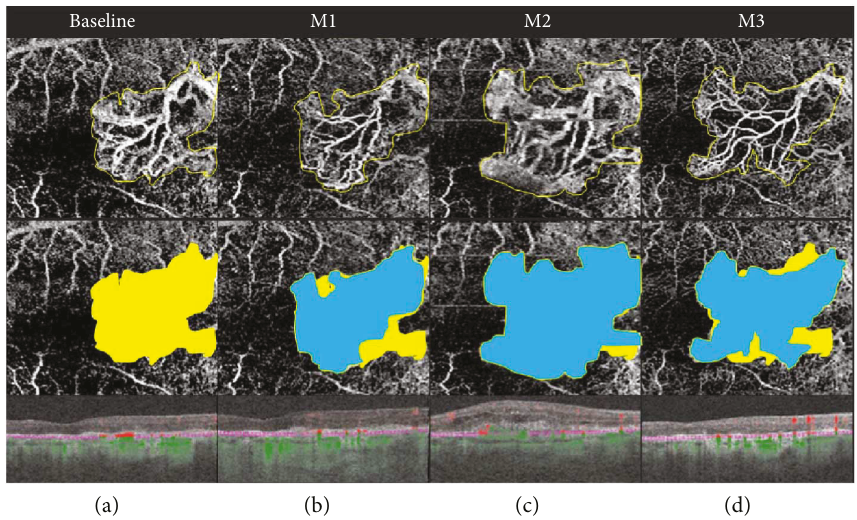
Figure 2: OCTA follow-up of previously treated choroidal neovascularization (CNV) associated to neovascular age-related macular degeneration (AMD) during pro re nata (as needed) regimen. Each column represents a visit; the upper row represents the quanti fi cation of CNV size on the outer retina to choriocapillaris (ORCC) slab; the lower row represents the comparison between the baseline lesion area (yellow) and follow-up CNV area (blue). Quantitative analysis demonstrated that at baseline, the area in the ORCC segmentation averaged 1.93mm 2 . Under anti-VEGF therapy, this area decreased to 1.85mm 2 , at month 1(M1). At month 2 (M2), the area increased to 2.92mm 2 , while at month 3 (M3), at the last follow-up visit, the CNV averaged 2.45mm 2 . Indeed, the CNV area slightly increased from baseline to month 3 by 26.94%. This expansion of the CNV size in treated patients has been noticed on the overall cohort ( P = 0 94 , Figure 3).